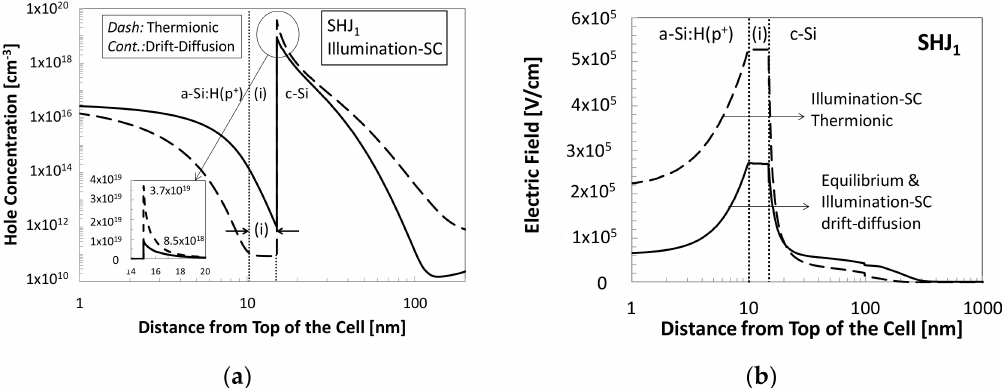
Figure 6. Simulated ( a ) hole concentration profile and ( b ) electric field distribution, in cell SHJ 1 under illumination-SC with thermionic emission transport ( Dash ) and drift-diffusion transport (also ~equilibrium) ( Cont. line ).